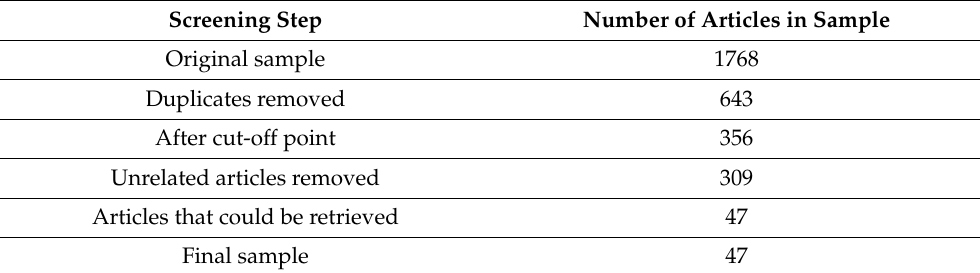
Table 3. Articles that resulted from this systemic